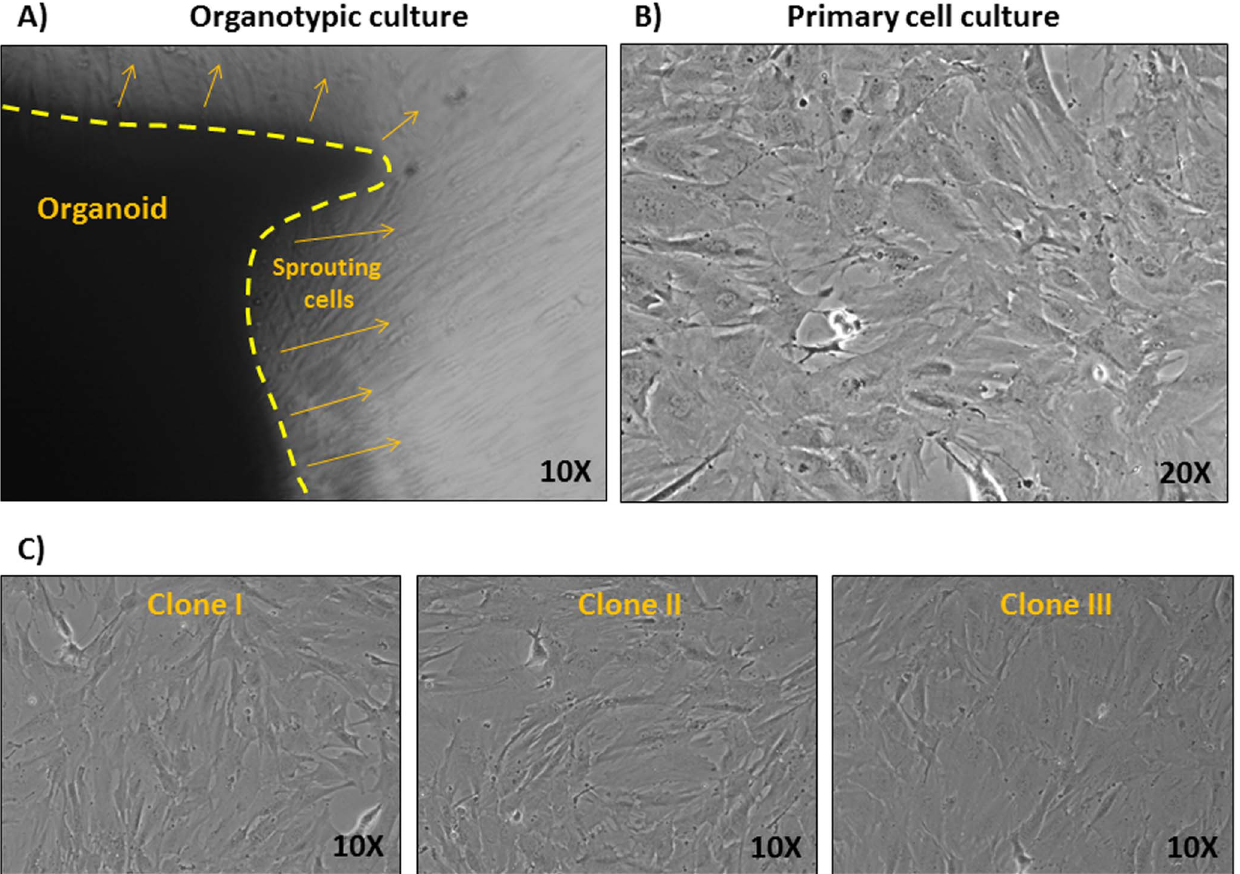
Figure 1. Generation of Alpaca organotypic culture. A) Representative phase contrast image (10x) of an Alpaca skin organoid, delimited by a yellow dotted line, with sprouting cells as indicated by yellow arrows. B) Representative phase contrast image (20x) of the first passage primary cell culture obtained from the cells sprouting from the organoids. C) Representative phase contrast images (10x) of three independent clones of cells after immortalization with SV40 large T antigen.